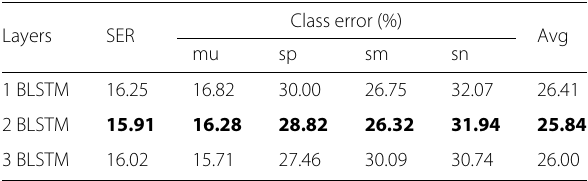
Table 3 SER, error per class and average class error for the RNN classifier on the test partition for the best frontend configurations and different number of stacked BLSTM layers Layers